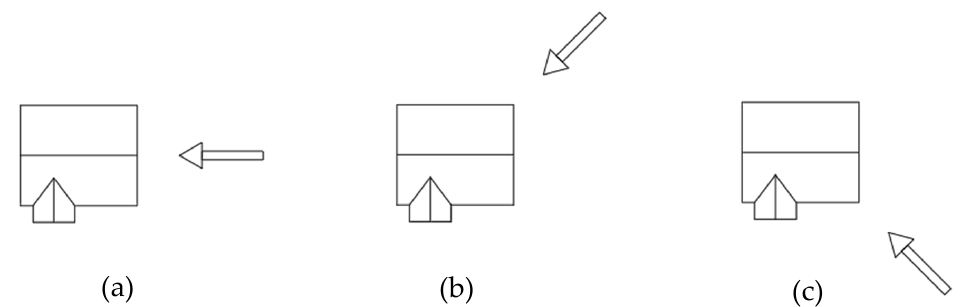
Figure 9. Directions of wind action assumed in the numerical analysis: ( a ) east—W1, ( b ) north-east—W2, ( c ) south-east—W3.